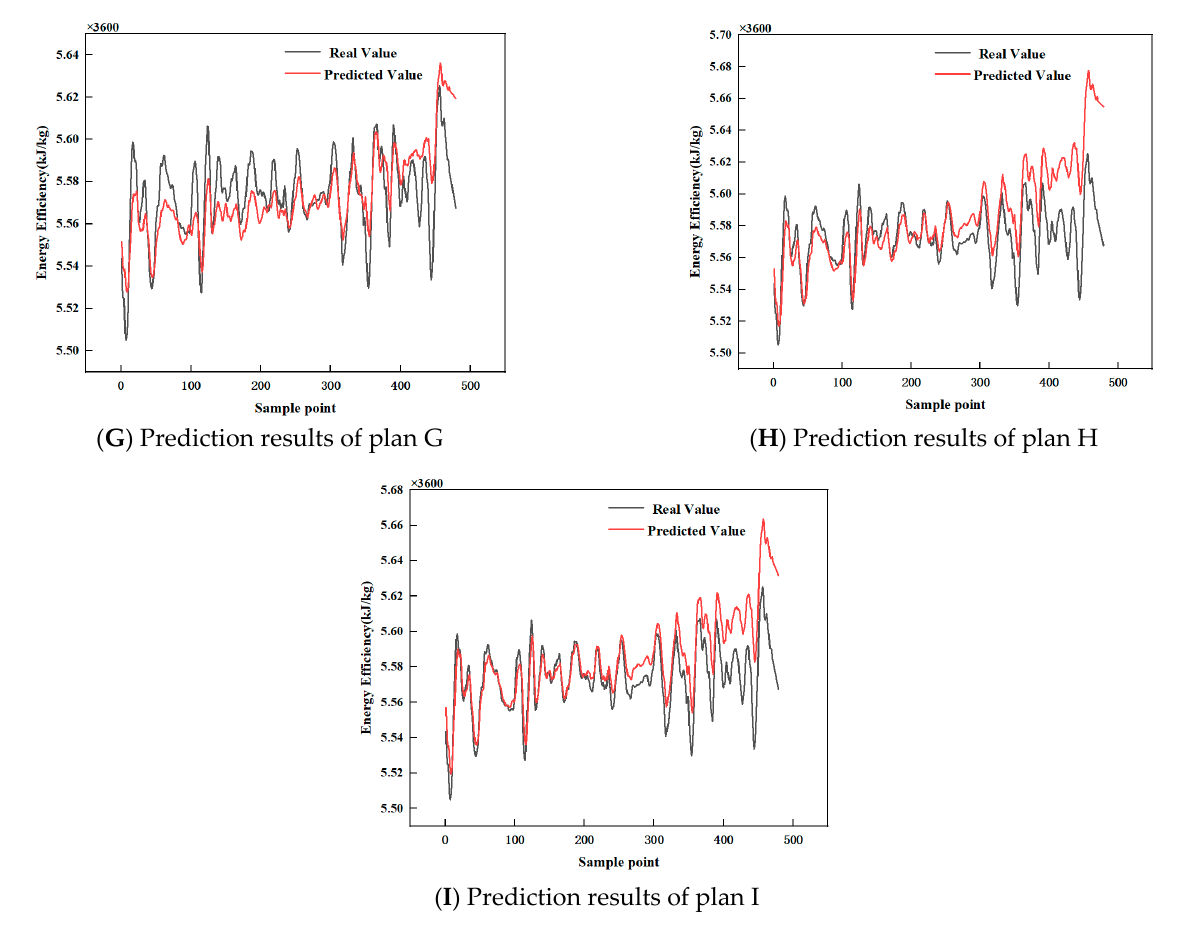
Figure 11. Comparison of prediction results of different hyperparameters.